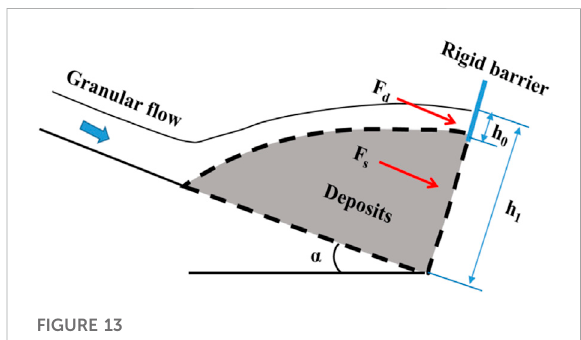
FIGURE 13 Diagram showing rigid barrier impacted by dry granular fl ow.